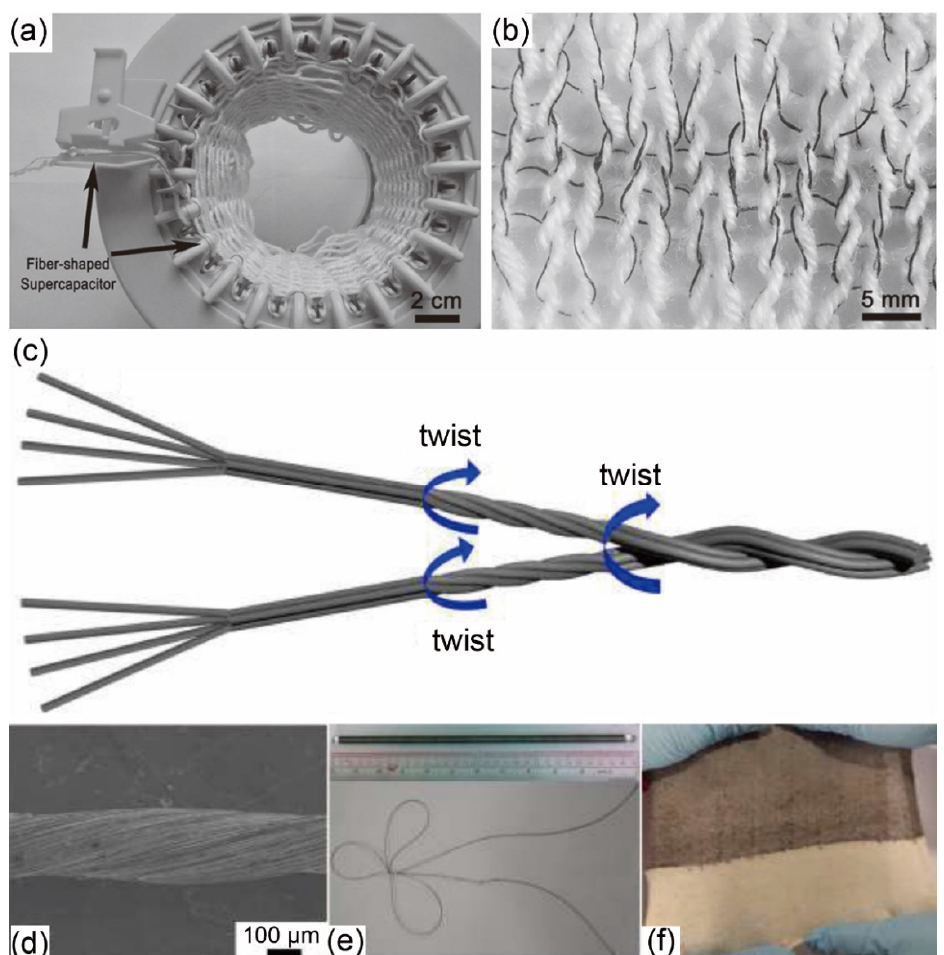
Figure 4. ( a ) Picture of the knitting process. ( b ) Cotton yarn (white) with integrated fiber-shaped supercapacitors (black). ( c ) Schematics of yarn fabrication. ( d ) Scanning electron microscopy (SEM) image of an as-drawn yarn. ( e ) A long yarn rolled on a rod and knotted. ( f ) A cloth knitted by the as-drawn yarn and cotton yarn. ( a , b ) Reproduced with permission from ref. [46] Copyright 2015 John Wiley and Sons. ( c – f ) Reproduced with permission from ref. [47] Copyright 2015 American Chemical Society.